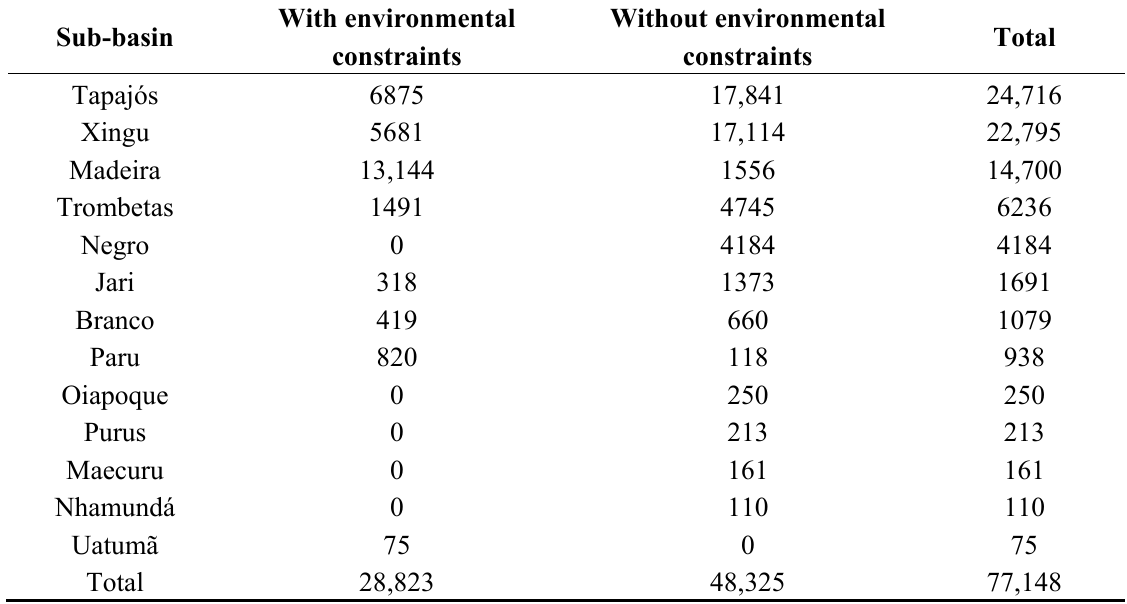
Table 2. Hydroelectric potential (MW) of the Amazon sub-basins with proportion of environmental